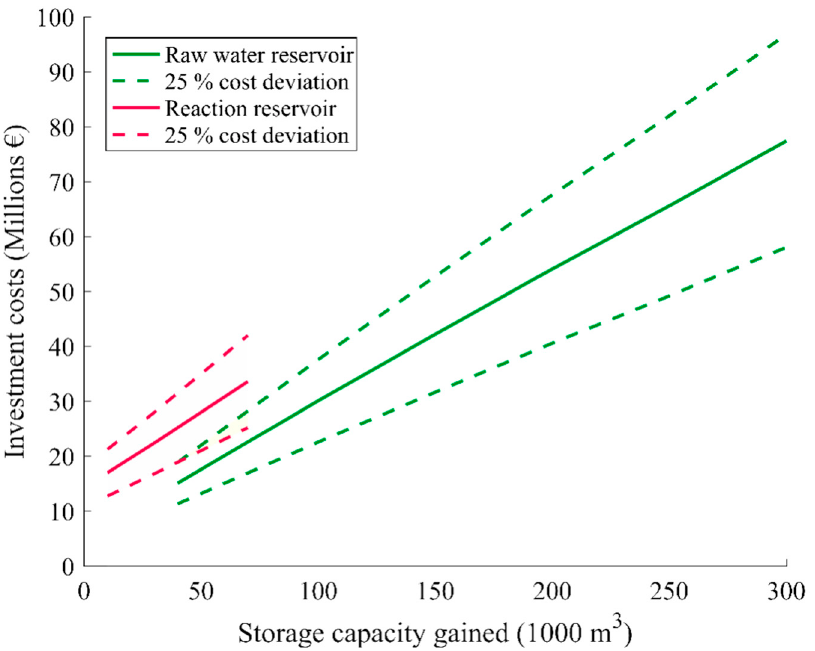
Figure 2 . Estimated average investment costs for varying storage capacity gained by type of reservoir.